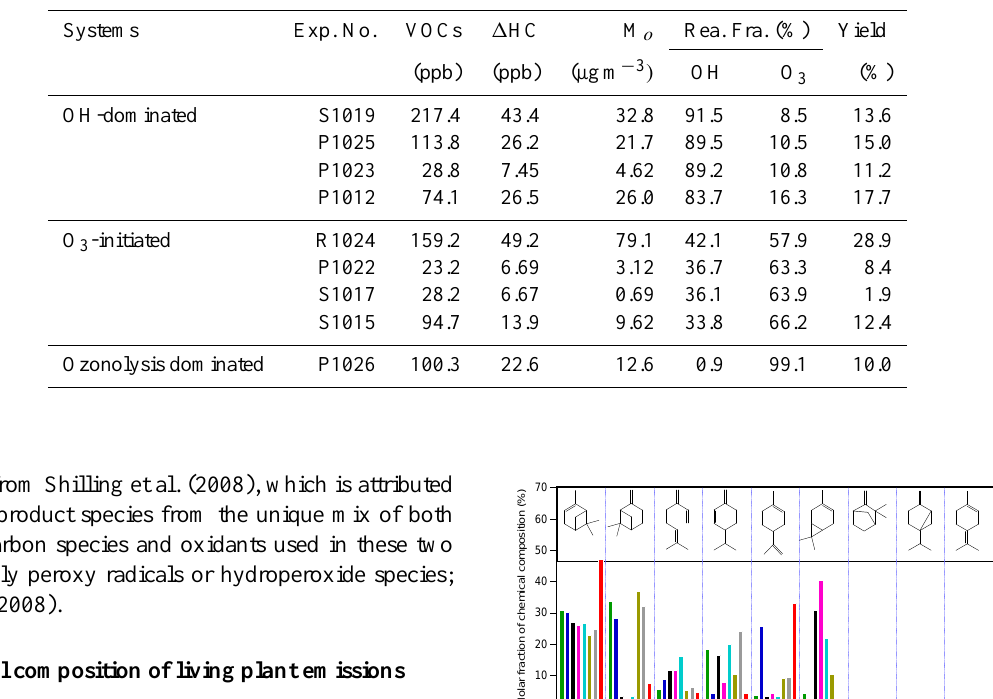
Table 2. SOA mass yields from OH and O 3 initiated oxidation of real emissions of two boreal forest trees. Reactivity fraction (Rea. Fra.) was calculated using Eqs. (11–12).